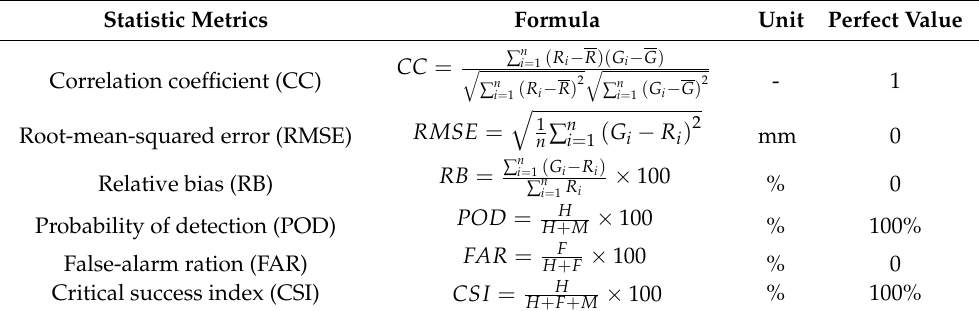
Table 3. List of the statistical metrics used for evaluating precipitation